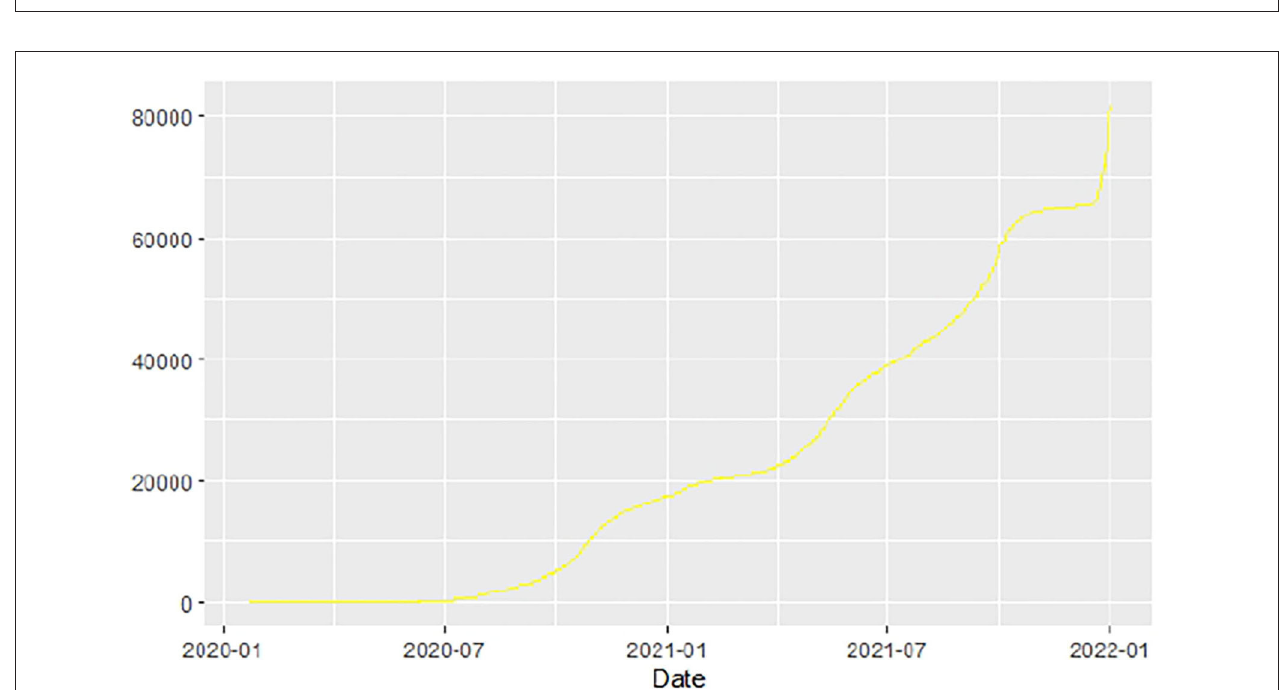
FIGURE 2 | Angola